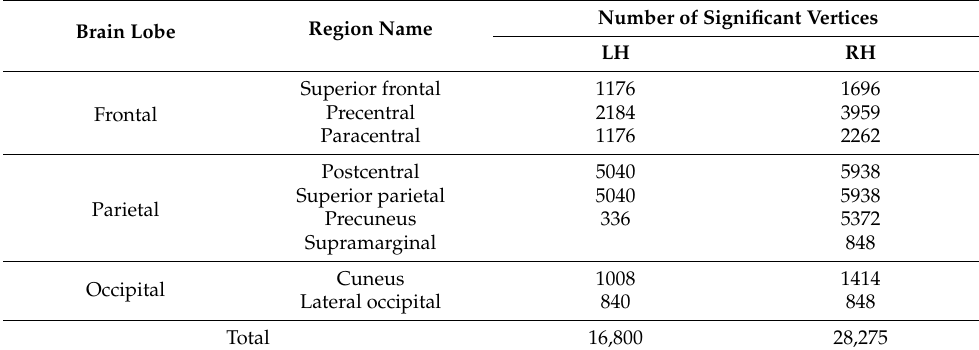
Table 3. Cortical regions and the number of vertices that show significant ( p < 0.05, corrected for multiple comparisons) negative correlation between EXE scores and cortical thickness in